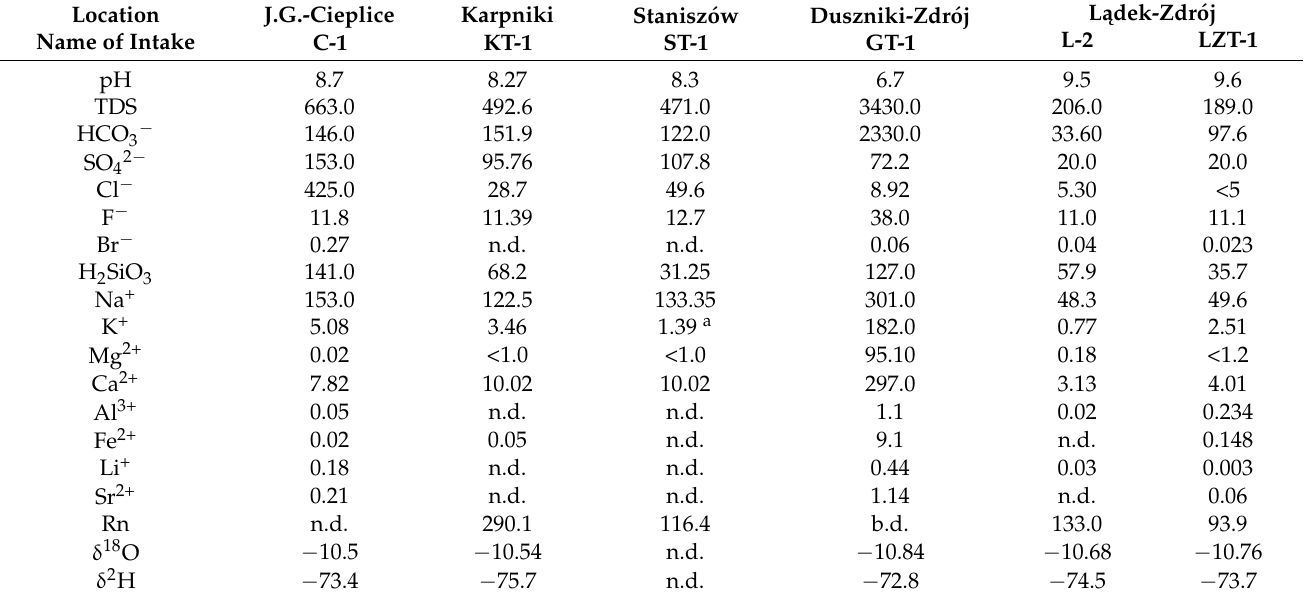
Table 2. Chemical and isotopic composition of thermal waters (based on [42-43,49,56]); J.G.-Cieplice—Jelenia Góra-Cieplice; concentration of elements in mg/L, radon activity in Bq/L.